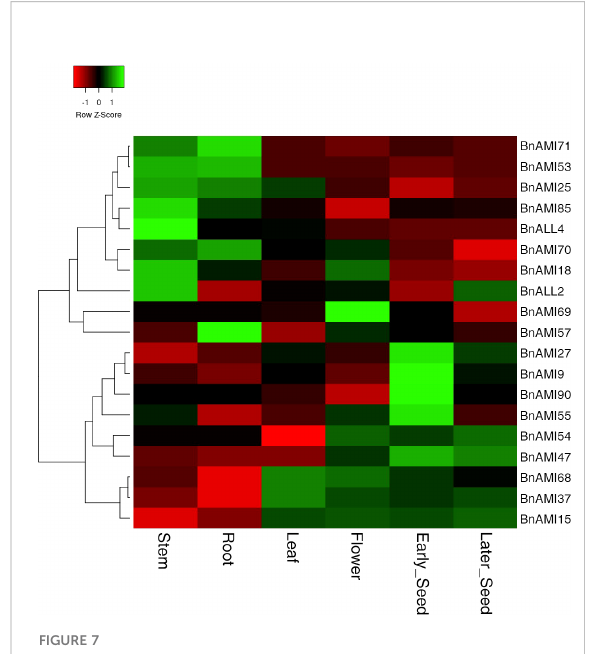
FIGURE 7 Hierarchical clustering of the expression pro fi les of BnTAR genes in different tissues. The color scale represents relative expression levels with high (green) or low (red). Early-developing seeds were got 14 days after fl owering, and later-developing seeds were 27 days after fl